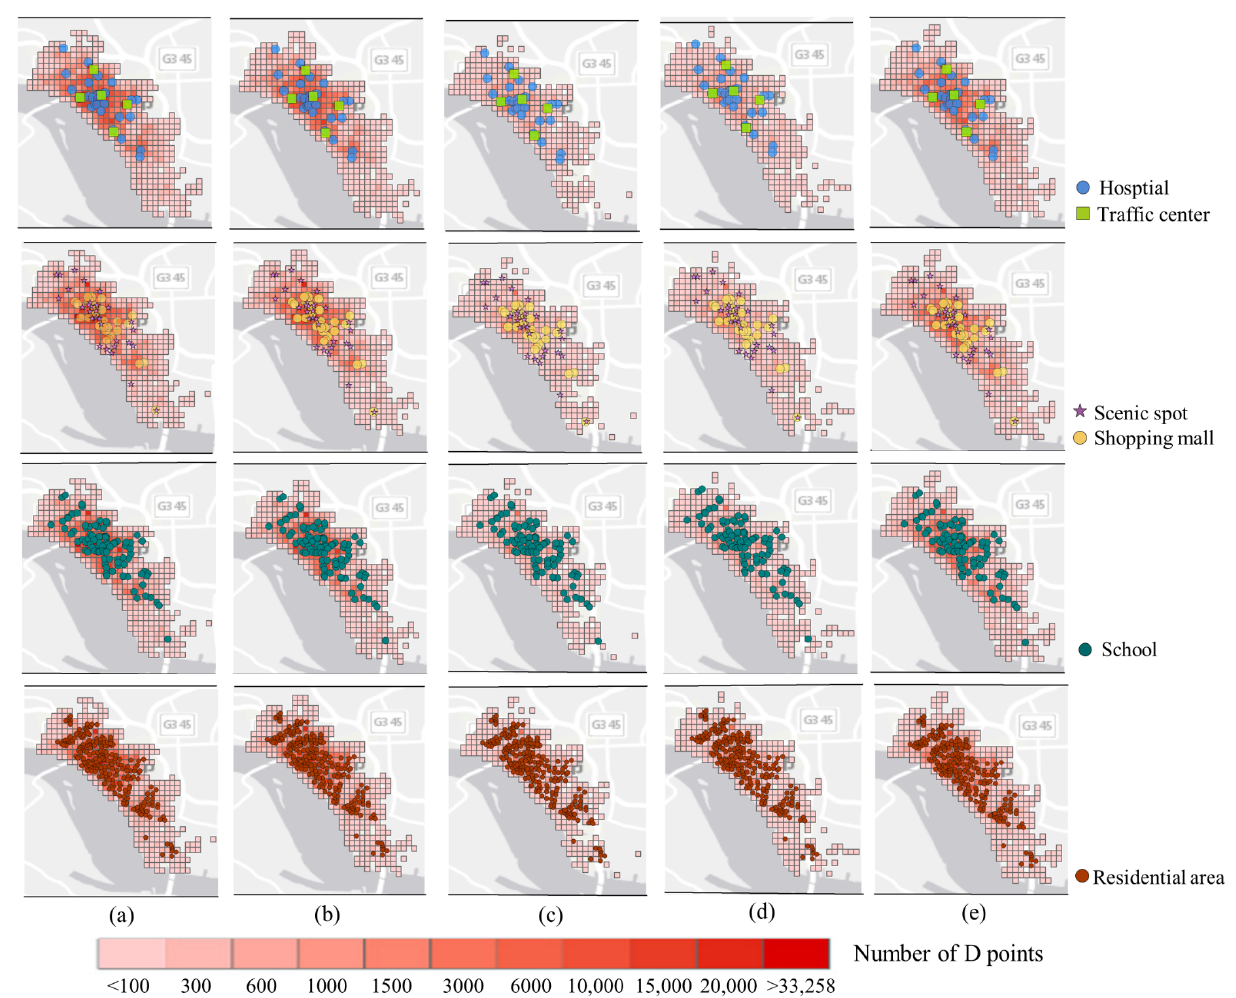
Figure 9. The density of D points around each UFA in ( a ) normal period of society, ( b ) early period of COVID-19, ( c ) outbreak period of COVID-19, ( d ) rework period of society, and ( e ) recovery period of society. D point represents the destination point in one trajectory of residential travel. Marked points were obtained from the center points of UFAs. The size of the grid is 1 km × 1 km.